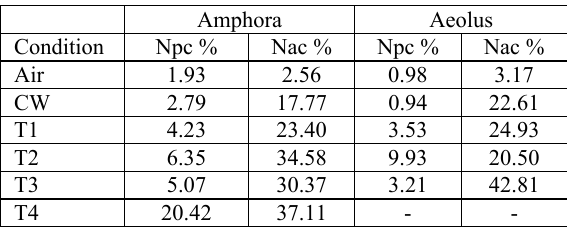
Table 3.: Percentage values of deleted 3D points for passive (Npc%) and active (Nac%) stereo techniques.